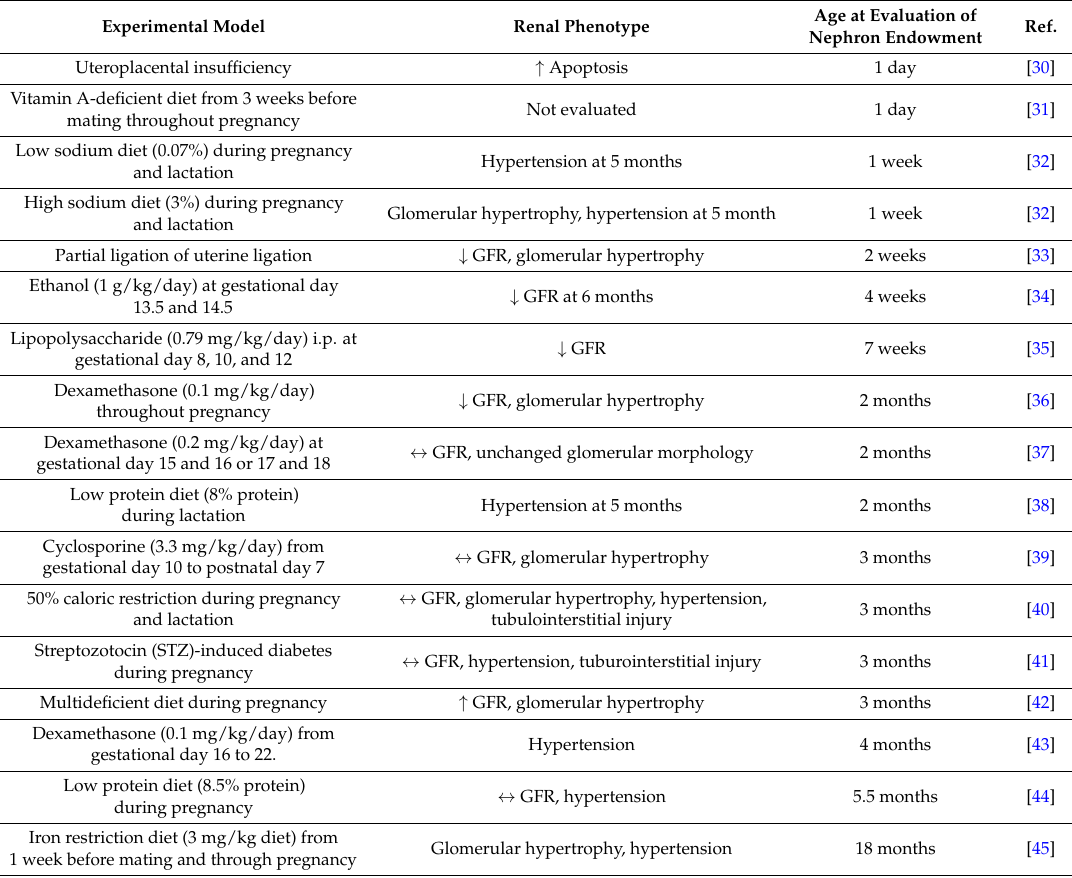
Table 1. Effects of early-life insults on renal programming with low nephron number in animal models. Experimental